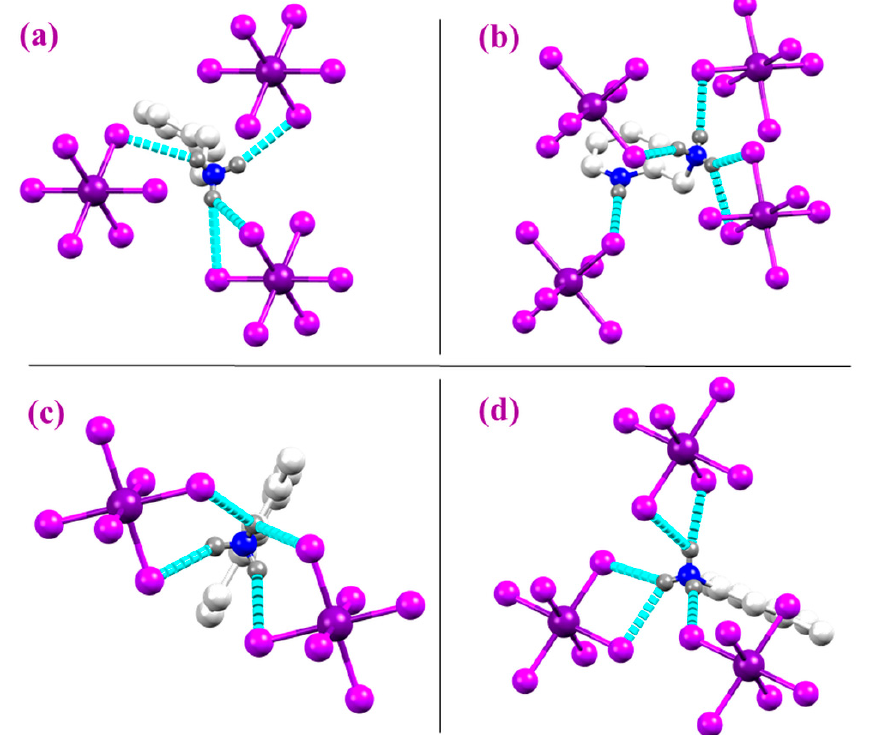
Figure 2. N-H ··· Cl hydrogen bond interactions in: ( a ) (NH 3 (CH 2 ) 2 C 6 H 5 ) 2 [SnCl 6 ], ( b ) (C 6 H 10 N 2 )[SnCl 6 ], ( c ) (C 9 H 14 N) 2 [SnCl 6 ], and ( d ) (C 8 H 12 N) 2 [SnCl 6 ]).